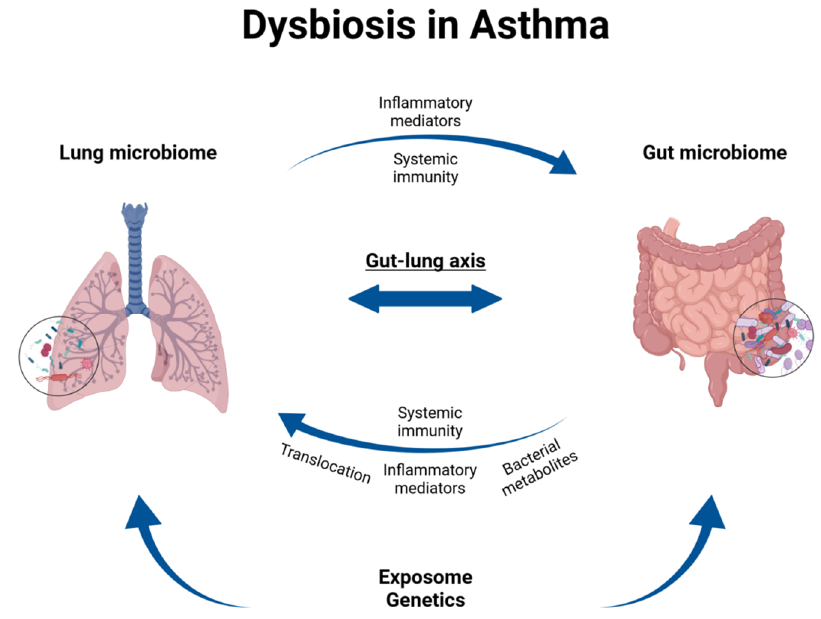
Figure 2. Schematic representation of dysbiosis in asthma. Exposome refers to factors such as environmental microbiota, allergens, air pollution, tobacco smoke, diet, medication and early-life expo- sures.